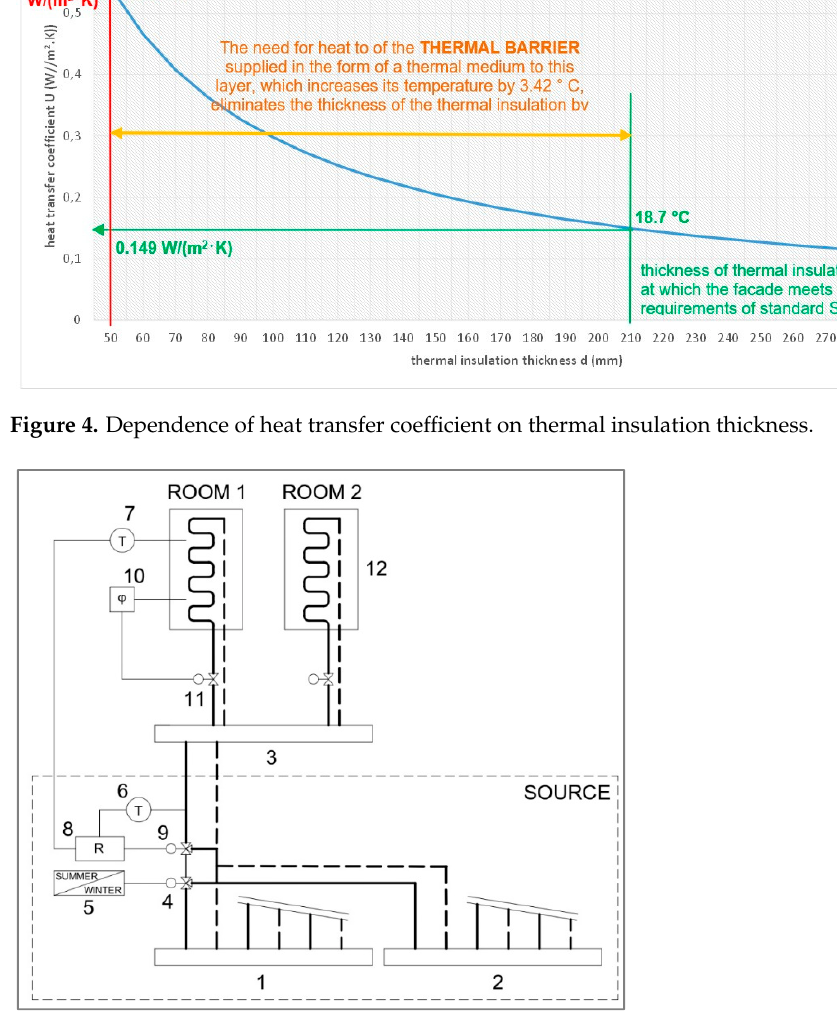
Figure 4. Dependence of heat transfer coefficient on thermal insulation thickness.